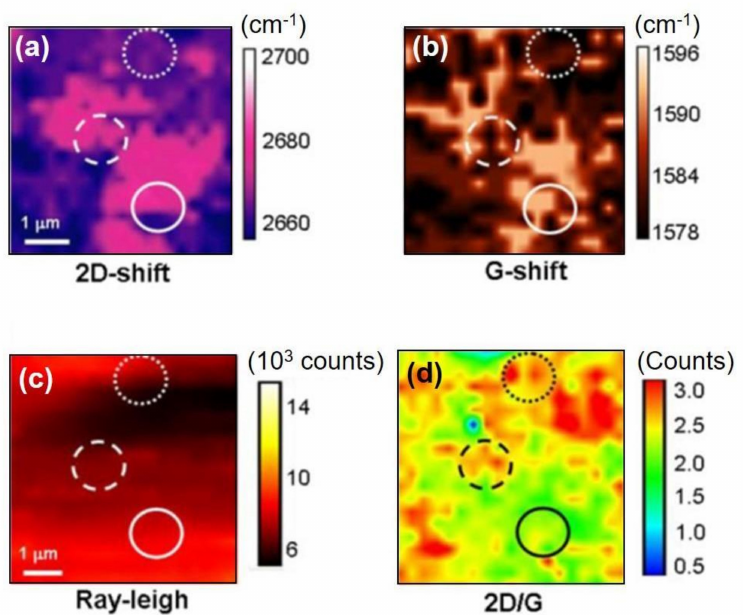
Figure 2. ( a , b ) were the 2D and G peak shift Raman images, respectively. Dotted and solid circle areas in each figure represented the regions where the largest variation in the shift was generated. ( c , d ) were the Rayleigh scattering and graphene thickness (2D/G) images, respectively. All images were reprinted with permission from ref. [6].